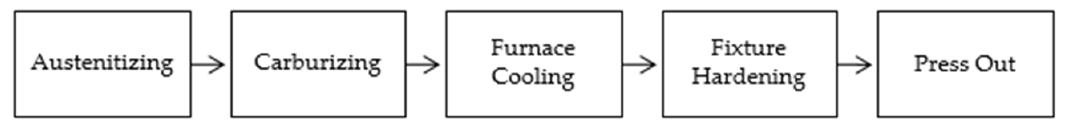
Figure 5. Simulated process steps.